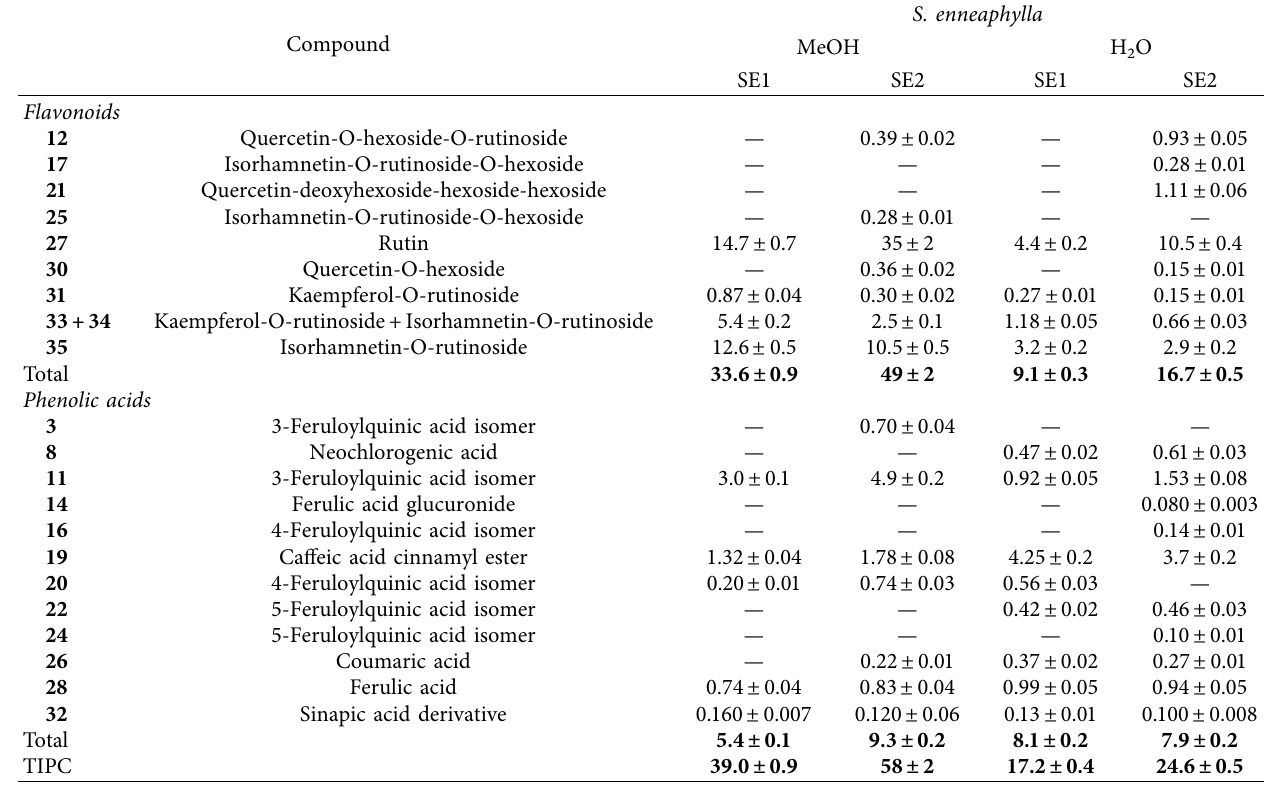
Table 3: Quantification of compounds in extracts of S. enneaphylla (SE) from two different locations, extracted in methanol and water.